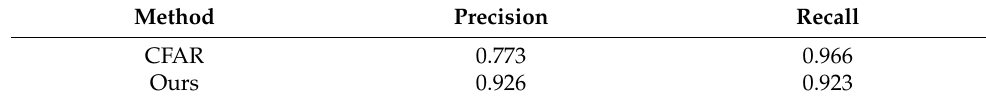
Table 5. Detection precision and recall rate of both two-parameter CFAR and our method. Compared with the former approach, ours removed more false alarms.